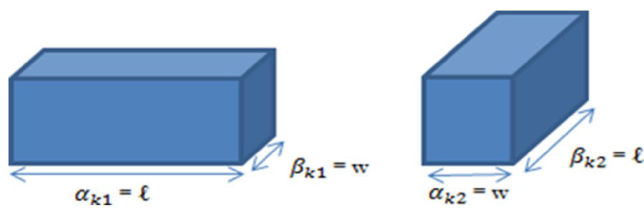
Figure 1. 2-Dimensional Box orientations